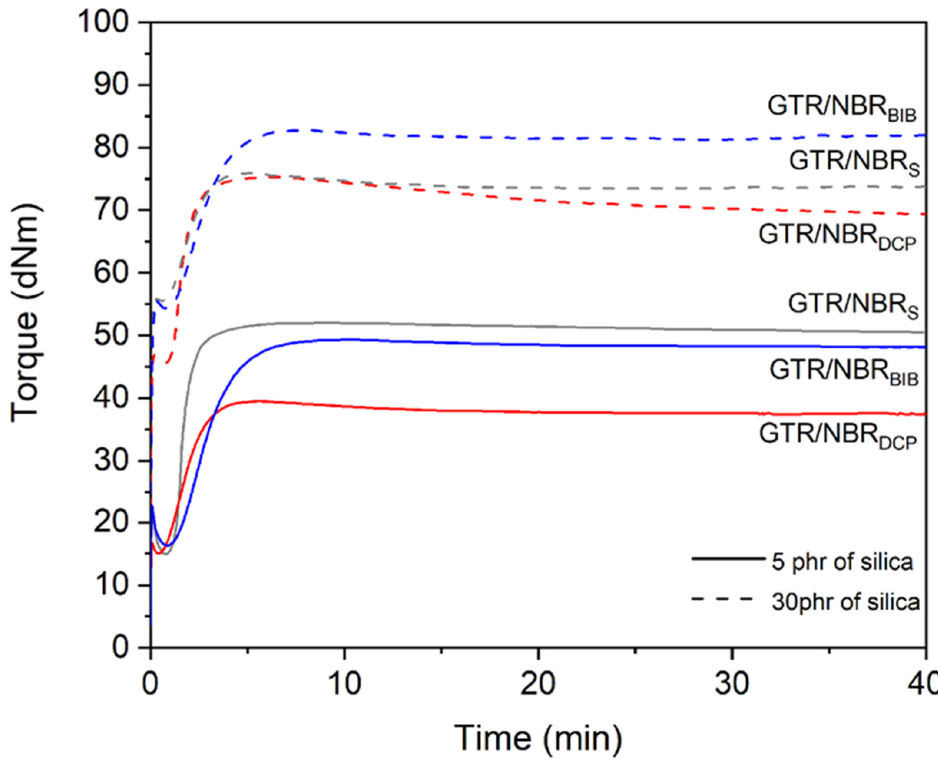
Figure 1. Curing curves of studied GTR/NBR performed at 160 ◦ C (sulfur curing system) and at 180 ◦ C (peroxides). Table 3. Curing characteristics of GTR/NBR composites as a function of curing system and silica content. Sample